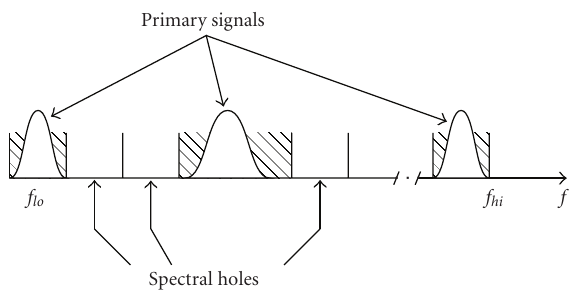
Figure 1: Schematic representation of the multiband